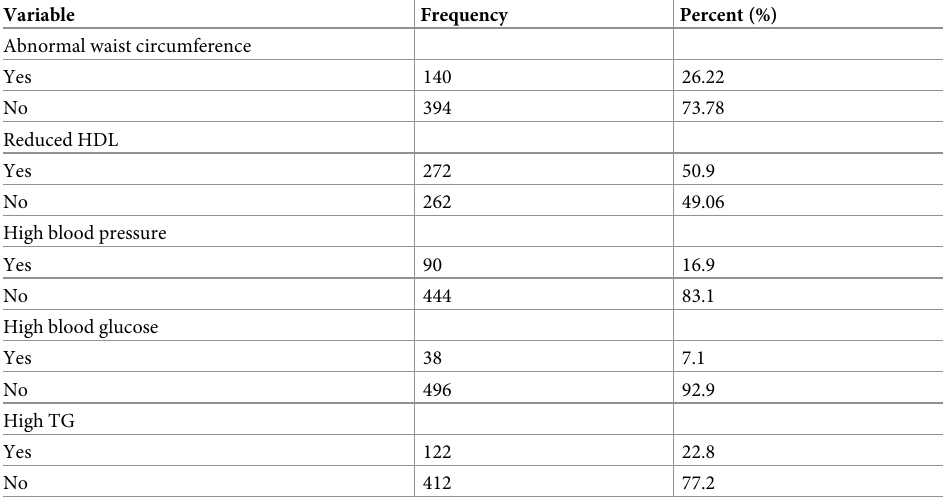
Table 4. Distribution of respondents by their waist circumference, HDL, blood pressure, level of TG and blood